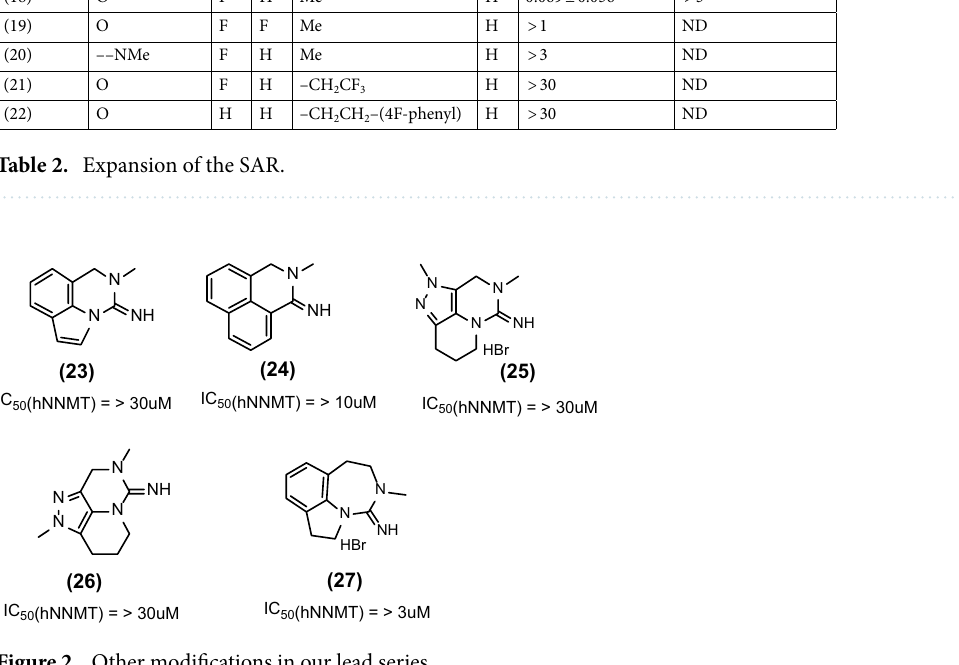
Figure 2. Other modifications in our lead series.